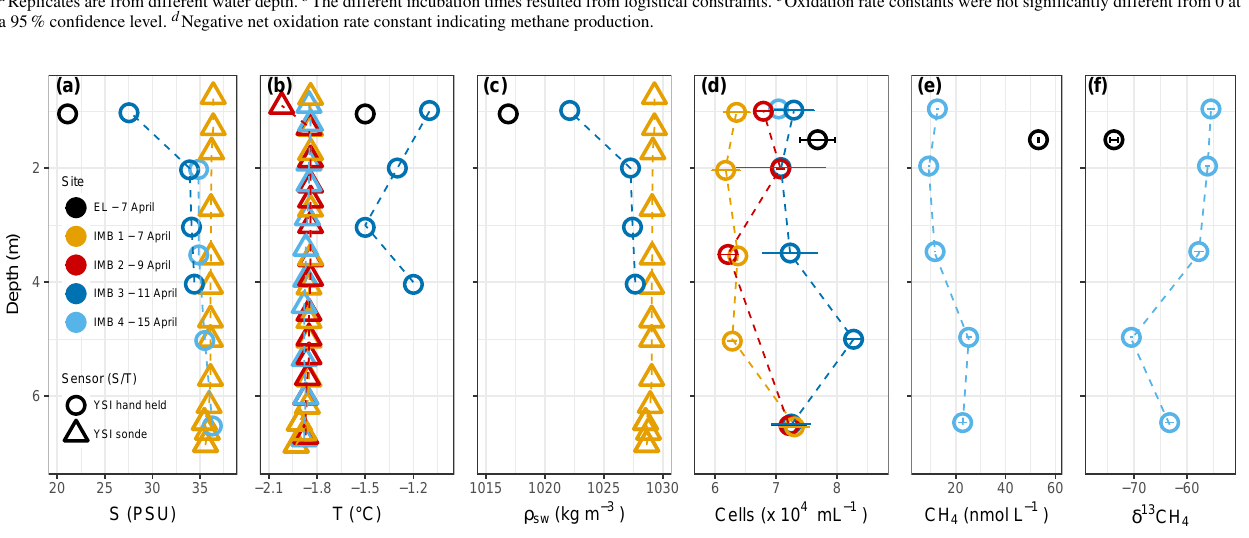
in situ water samples analyzed for 16S diversity (Fig. 4).